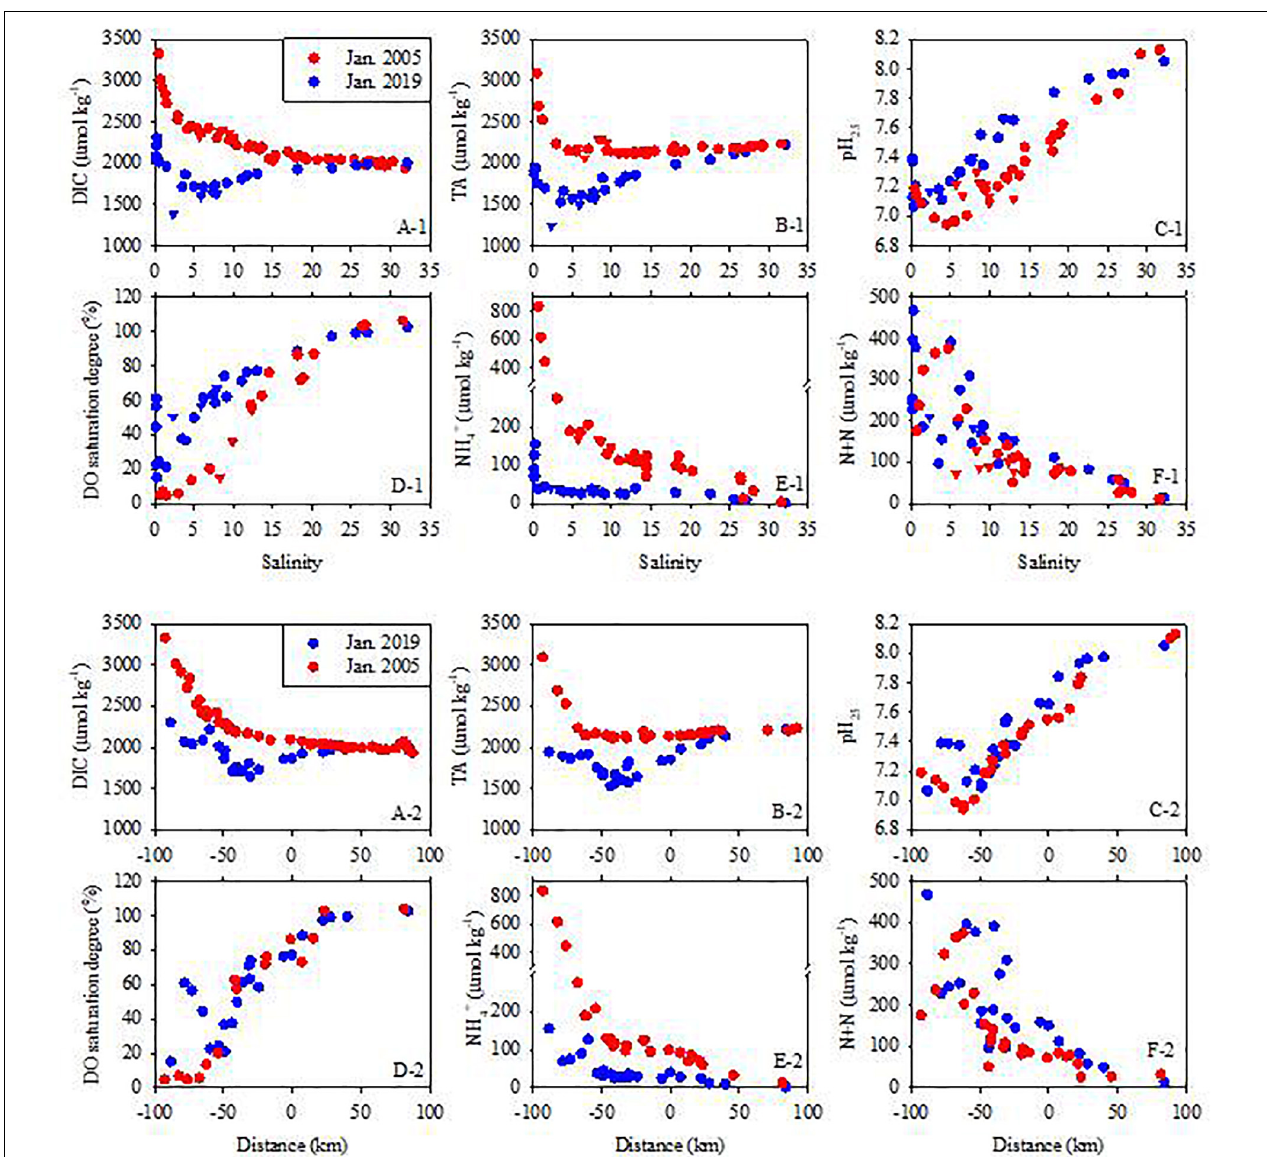
FIGURE 5 | DIC, TA, pH 25 , DO, ammonium and N + N concentrations in surface water in January of 2005 and 2019. The distance is from Humen Outlet with negative values indicating upstream and positive values downstream locations. The triangles represent the data collected in the lower branches of the East River. For the January 2005 cruise, DIC, TA and pH 25 data are from Guo et al. (2008), and nutrient data are from Dai et al. (2008). Legends are the same for all panels.